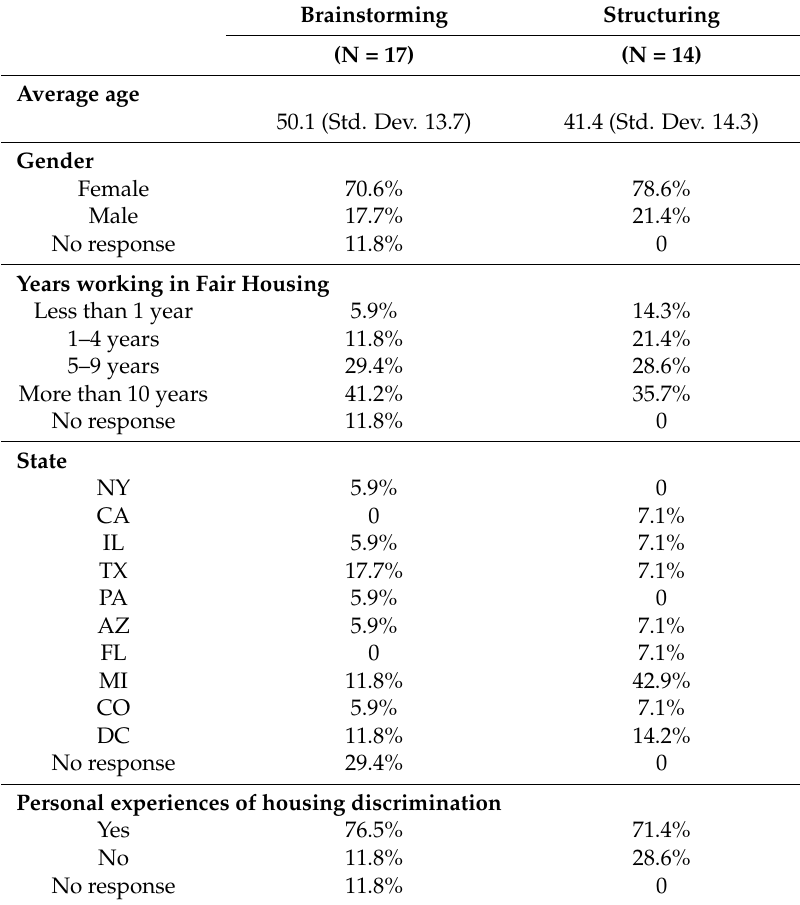
Table 1. Characteristics of participants for the brainstorming and structuring